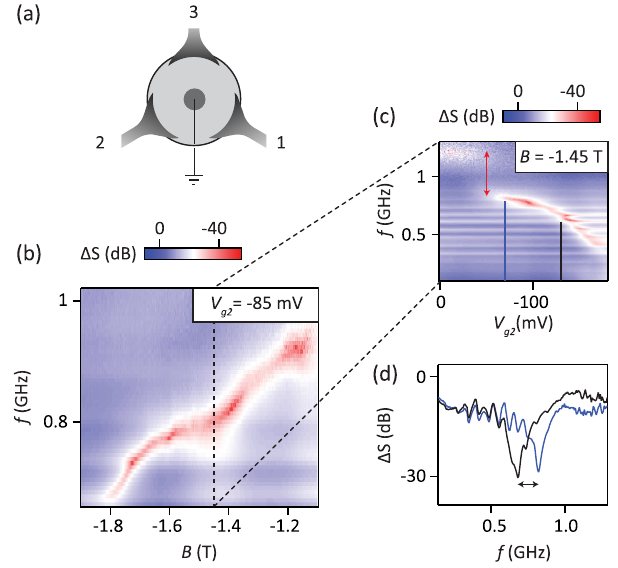
FIG. 5. (a) Schematic of the gate-tunable device, with ports overlapping the edge of the disk and a grounded contact on the mesa. Bias tees enable the application of both rf and dc voltages. A large nonreciprocity Δ S ¼ S 13 - S 23 is observed as a function ¼ − 85 mV. At of magnetic field, as shown in (b) for the case V g 2 fixed negative magnetic field values, varying V is found to g 2 affect the path from ports 3 to 1, and this produces a significant modulation in the frequency response of the circulator [shown in (c) and (d)]. This response is mirrored with a change of sign Δ S at positive magnetic field values, where the direction of EMP propagation is reversed and V is varied (see Ref. [28]). The g 1 red arrow in (c) indicates a discontinuous jump in frequency as a gate voltage is first applied, while vertical lines show the positions of 1D cuts presented in (d). Horizontal striations in (c) are the result of small standing waves associated with an impedance mismatch between the amplifier and the